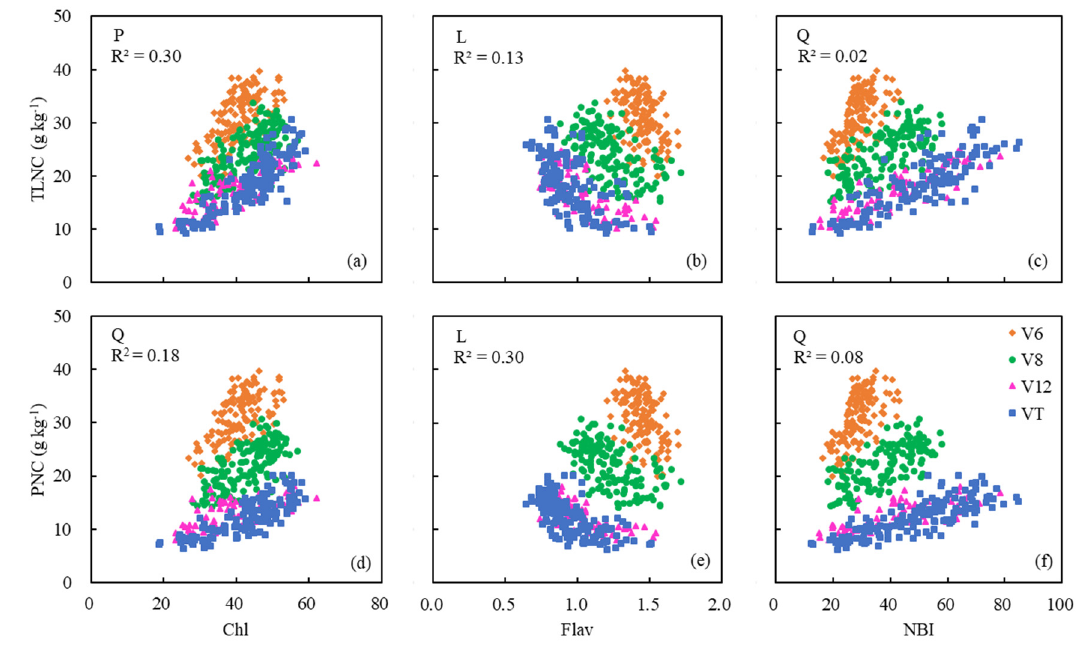
Figure 6. Relationships between original Dualex 4 parameters (Chl ( a , d ), Flav ( b , e ), and NBI ( c , f )) for the mean values of three di ff erently positioned leaves and two N status indicators (TLNC ( a – c )) and PNC ( d – f )) across growth stages. The models with the highest R 2 are displayed, with L ( e ), P ( a ), and Q ( d ) indicating linear, power, and quadratic models, respectively.